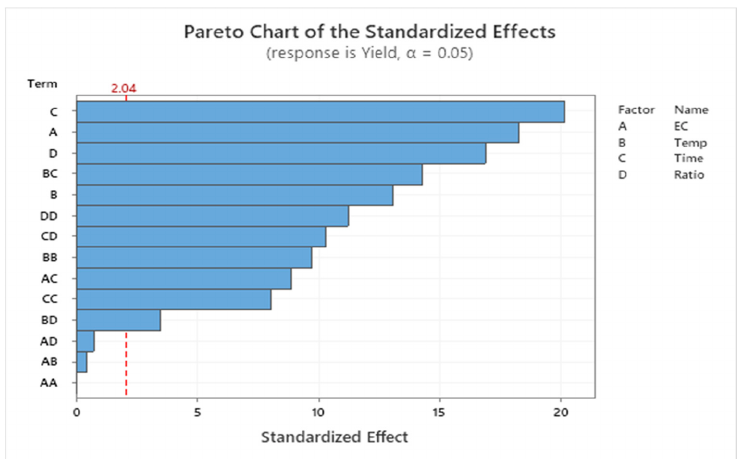
Figure 4. Pareto chart for the effect of factors on biodiesel conversion yield (EC: enzyme concentration; Temp: temperature; Ratio: oil/alcohol molar ratio).